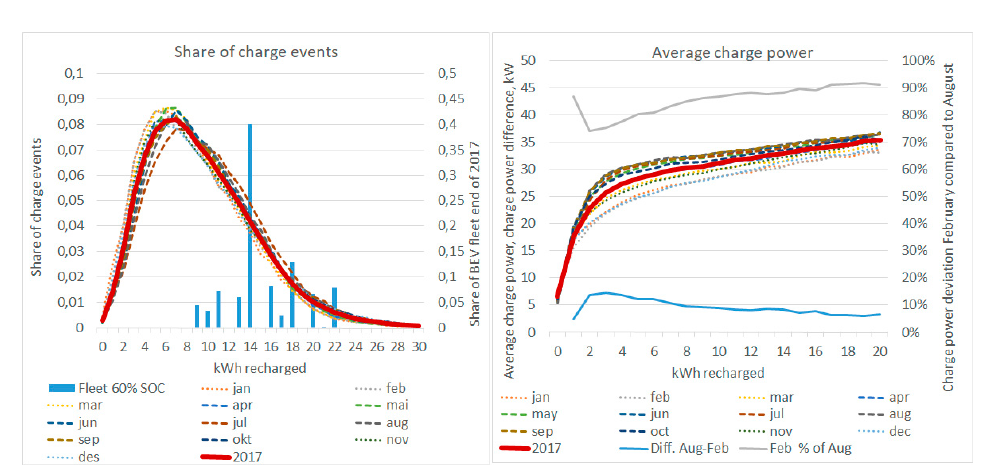
Figure 12. Variation over the year of the average energy charged, the average time used for charging and the average achieved charge power during the charge session. January 2016 to December 2017. Source: Dataset 1 and own analysis.